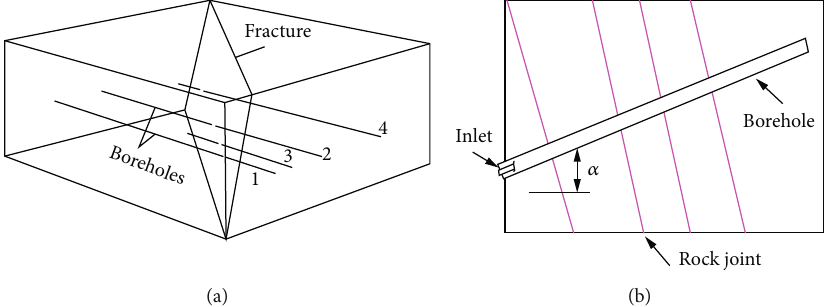
Figure 2: Sketch maps of boreholes and inclined fractures: (a) a steep fracture penetrated by boreholes [4]; (b) four fractures with steep dip angle penetrated by a borehole in tunnel excavation [1].